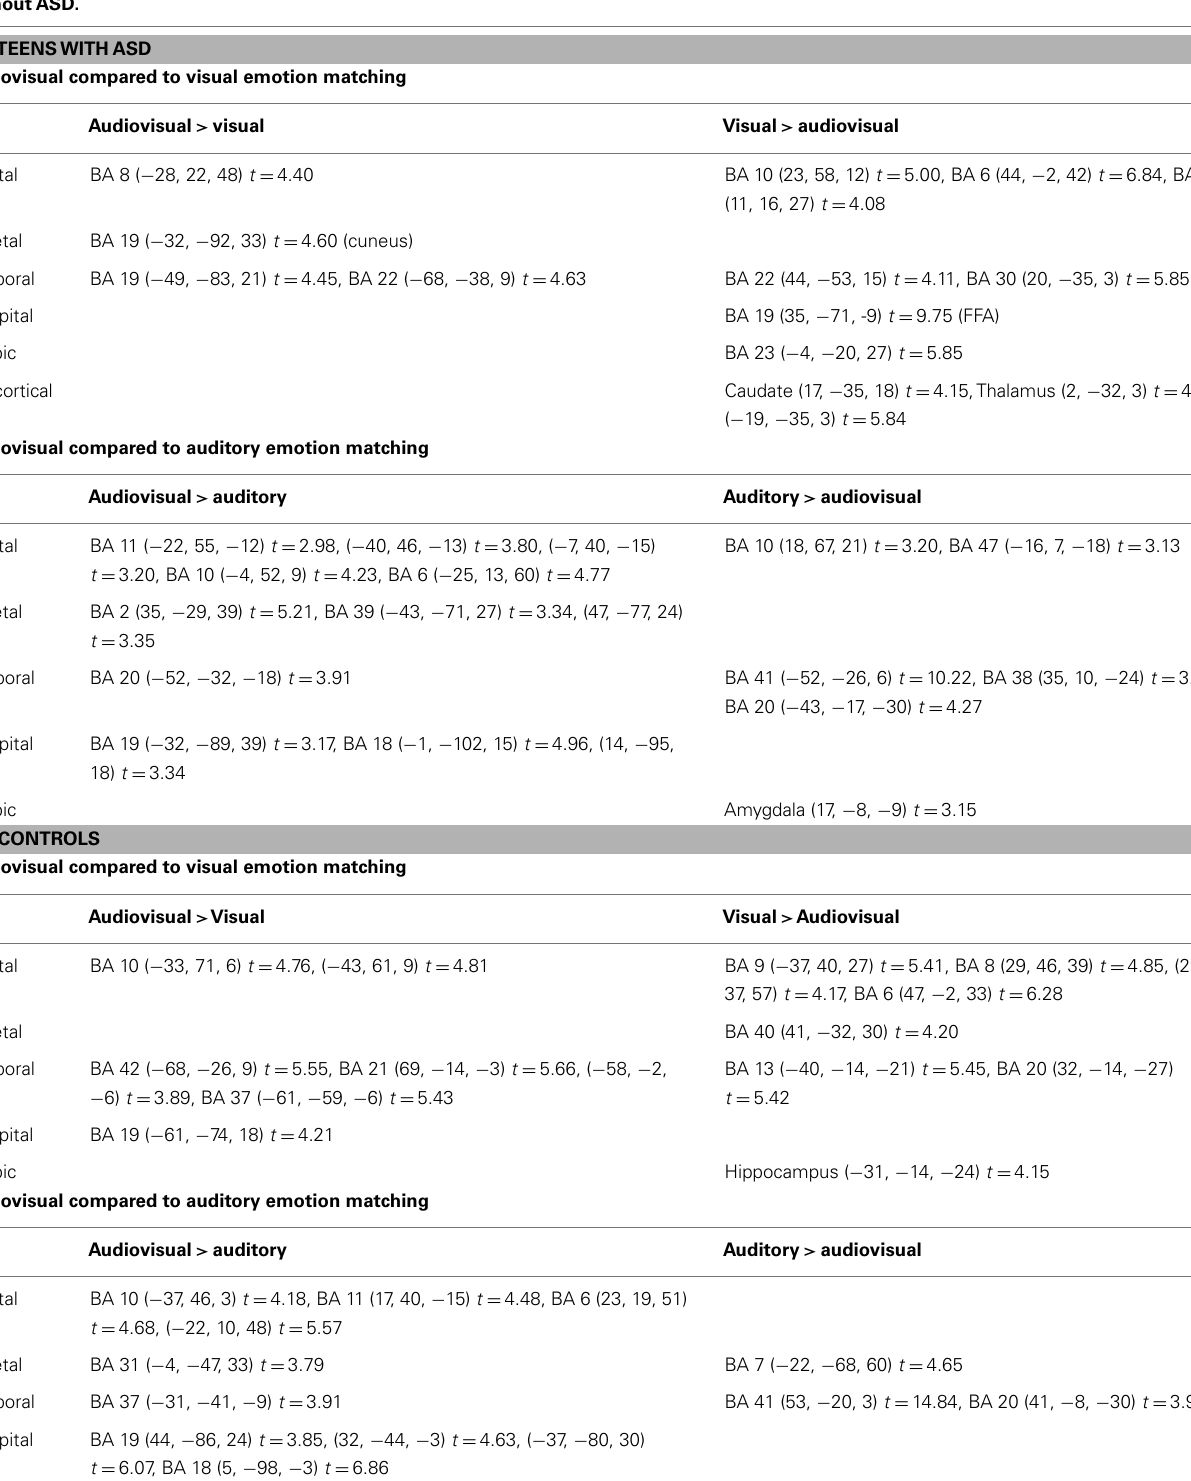
Table 3 | Significant brain activation differences observed between audiovisual, and visual or auditory emotion matching in teens with and